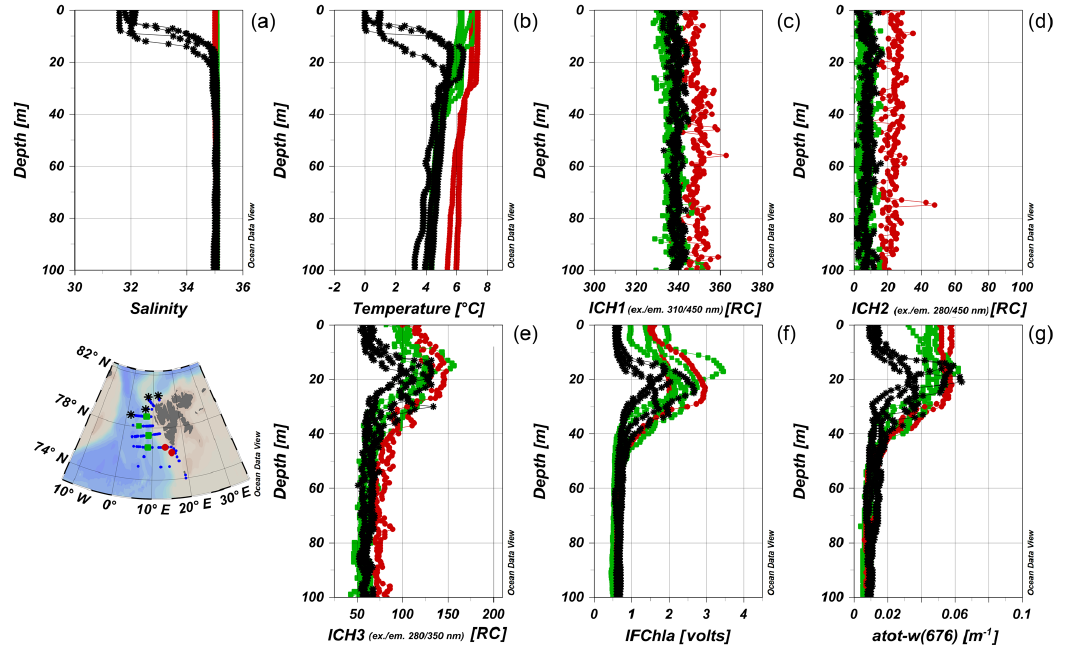
Figure 4. Vertical profiles of salinity (a) , temperature (b) , and different FDOM components: marine humic-like FDOM ( I CH1 , c ), terrestrial humic-like fraction of DOM ( I CH2 , d ), protein-like FDOM ( I CH3 , e ), chlorophyll a fluorescence ( I F Chla , f ), and total non-water absorption coefficient at 676nm ( a tot − w (676), g ) in 2014. Red dot, green square, and black star symbols correspond to vertical profiles obtained over the West Spitsbergen Shelf (influenced by SC), in the core of the WSC, and near the ice edge (with a presence of PSWw in the surface 0–20m layer),